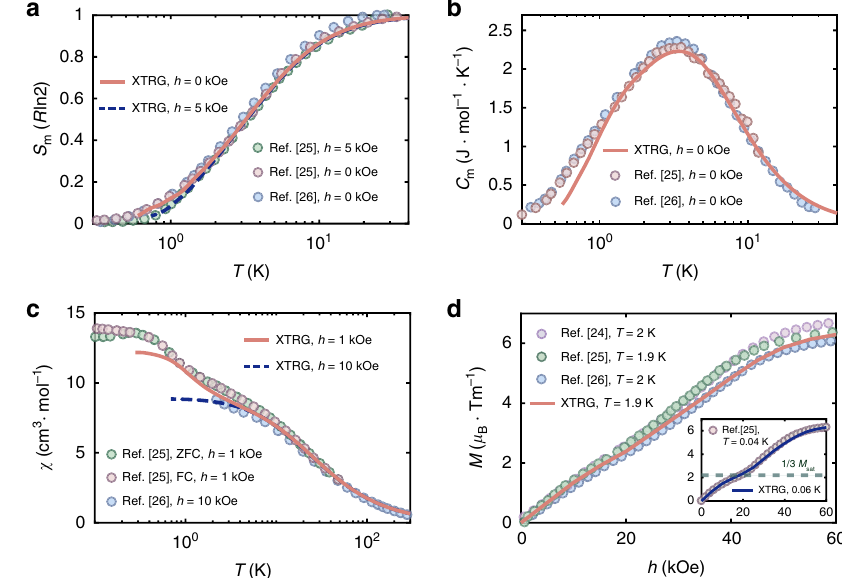
Fig. 2 Thermodynamic measurements and XTRG fi ttings to experimental results. Agreements between the experimental curves (taken from various independent measurements 24 – 26 ) and numerical results can be seen in all panels, down to very low temperatures. a Includes two experimental entropy curves under fi elds h = 0 and 5 kOe 25,26 , and the speci fi c heat data shown in b are under zero fi eld. The magnetic susceptibility χ is shown in c , which follows fi rst the Curie-Weiss law at high temperature, i.e., χ ~ C/ ( T − Θ ) with Θ ≃ − 19 K (see Supplementary Note 5) and then exhibits at ~10 K a shoulder (cid:4) 4 K, χ rises up again and eventually converges to a fi nite value as T decreases structure, signifying the onset of antiferromagnetic correlation. For T ≲ T (cid:3) h (cid:4) 1 K. These anomalous susceptibility curves can be fi tted very well by our simulations and naturally understood within the TLI model. For the to below T (cid:3) l magnetization curves in d , the perfect consistency between numerics and experiments hold for both intermediate- T ( ≃ 2 K) and the low- T (40 – 60 mK) curves. The latter is shown in the inset, where a quasi-plateau at M ’ 1 M becomes prominent, with M sat = Jg J μ B the saturation magnetization of sat 3